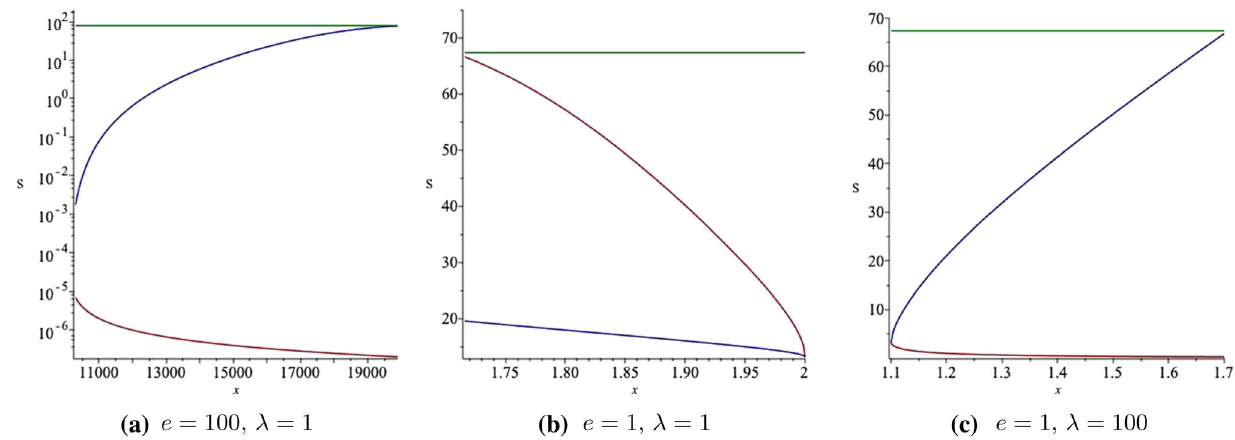
Fig. 2 The entropy functions with κ = (cid:4) = r 0 = 1. The green, red, and blue curves are the graphs of S I , S +